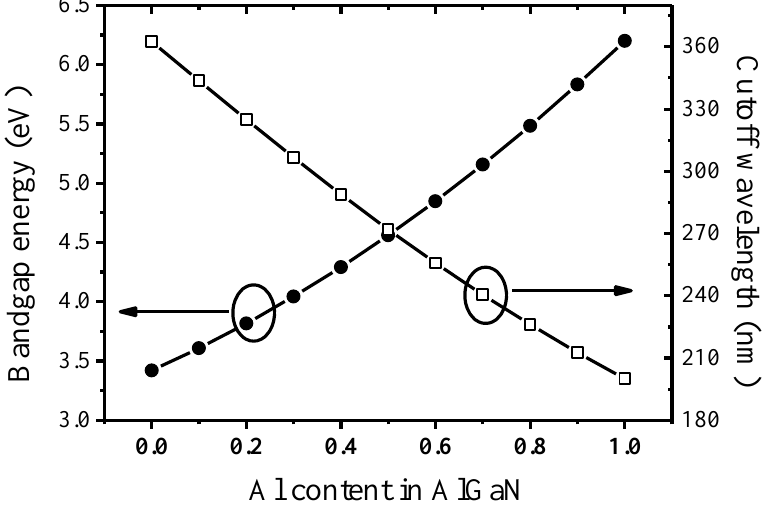
Figure 1. Bandgap and cutoff wavelength of AlGaN dependent on the Al mole